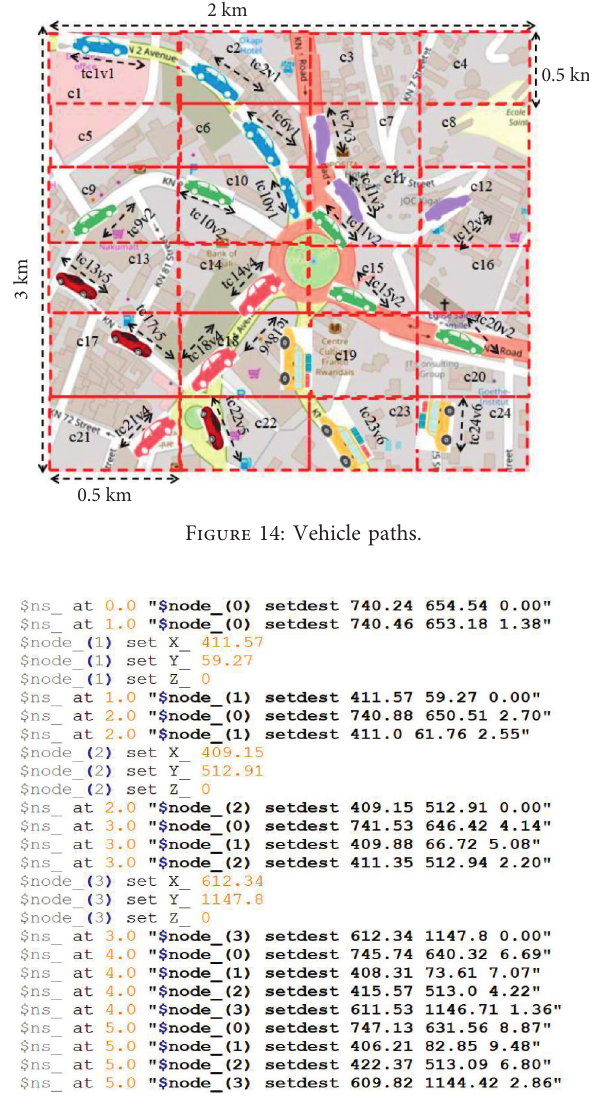
Figure 15: Vehicle positions in the mobility file.